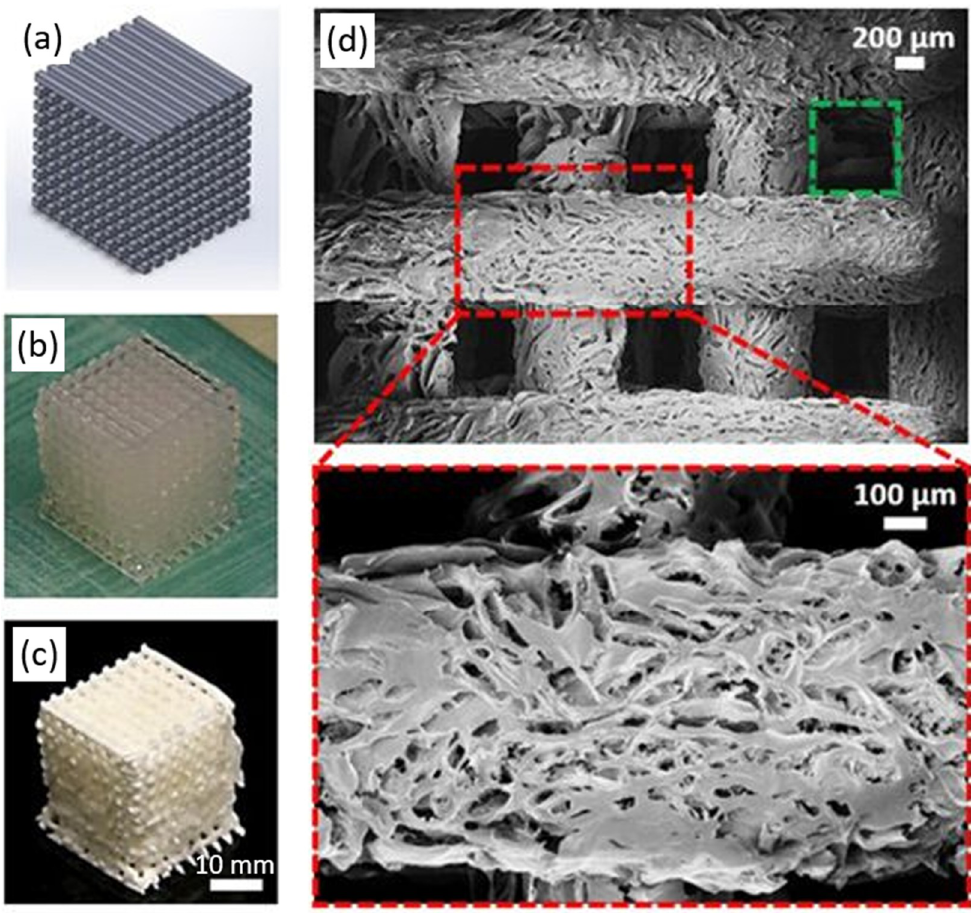
Figure 8. 3D printed scaffold obtained using a direct ink write (DIW) approach: ( a ) CAD model, ( b ) 3D structure obtained after direct printing of a 20 wt% CNC gel and ( c ) final structure obtained after freezing in a freezer at a temperature of −20 °C and sublimation. ( d ) SEM images showing the dual scale porosity of the fabricated materials: large pores of about 600‐μm diameter (green box) defined by the extrusion process coexist with finer elongated pores (red box) induced by the ice‐templating process. (Reproduced with permission from Li et al. [132]).